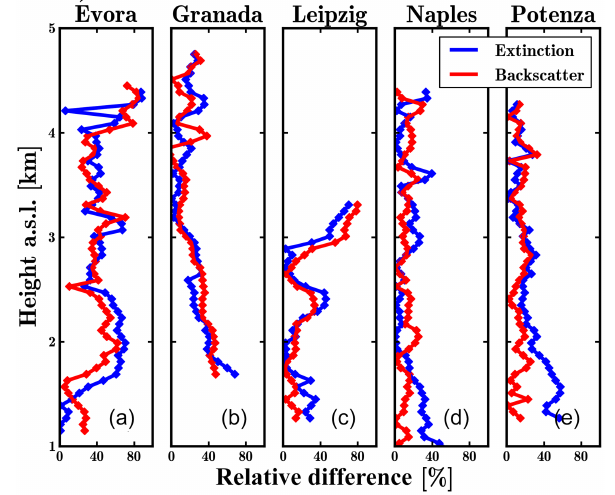
Figure 11. Relative difference of extinction and backscatter coeffi- cient for each considered